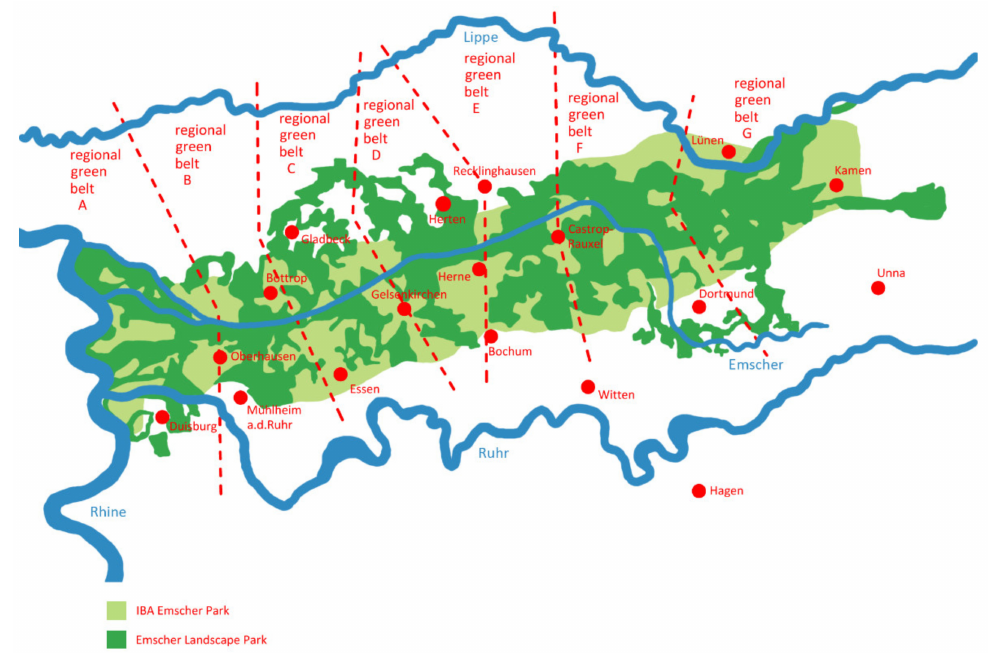
Figure 11. Summary of green areas along the Emscher River in the Ruhr area. Source: link.springer.com/book/10.1007/97 8-4-431-56445-4 (accessed on 22 July 2021).